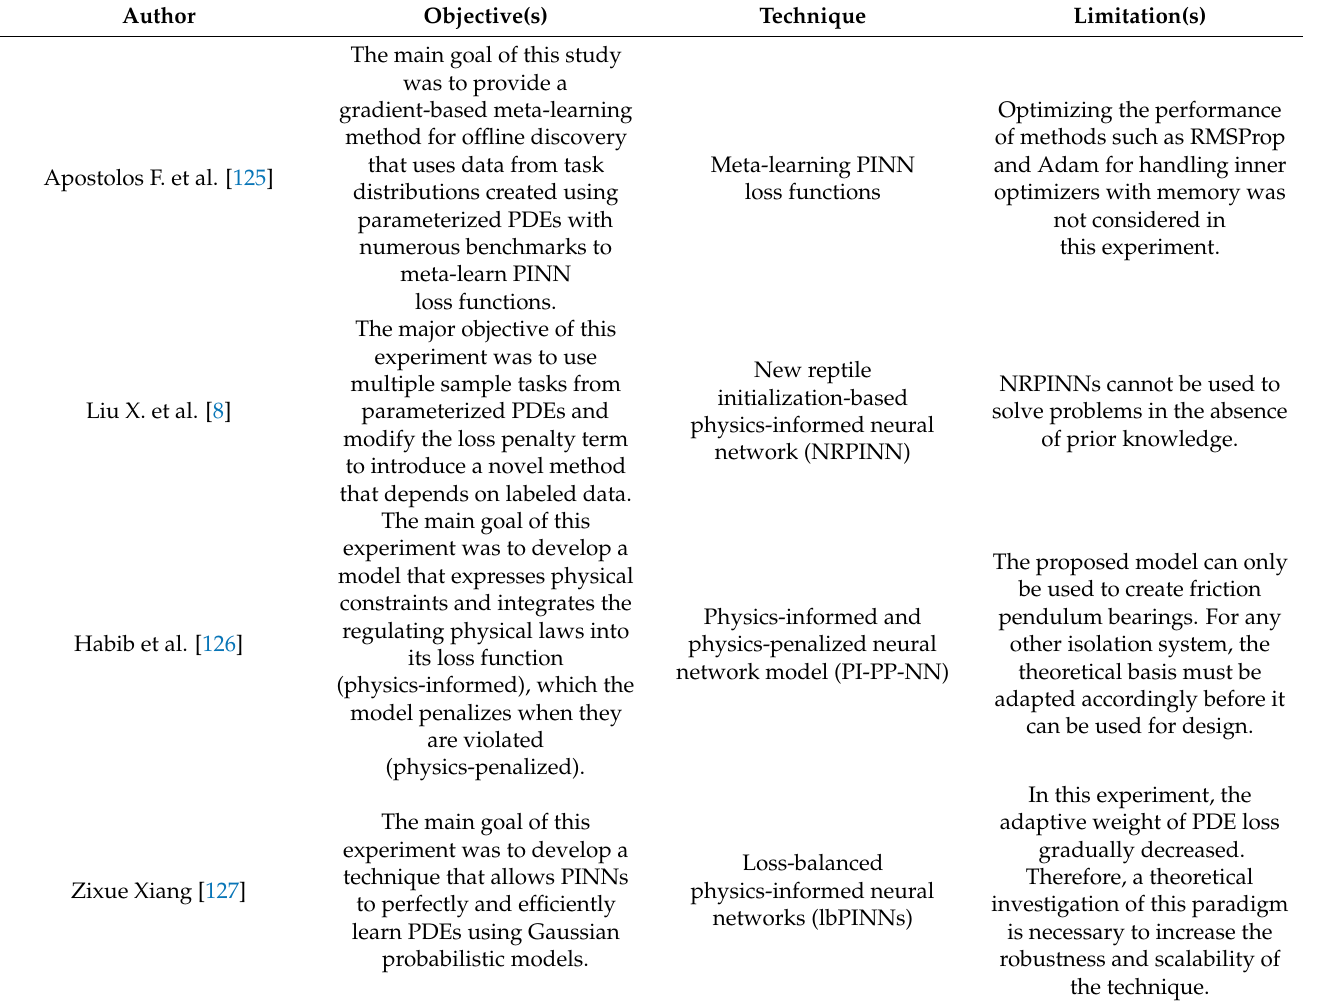
Table 5. Proposed PINN techniques using Minimized